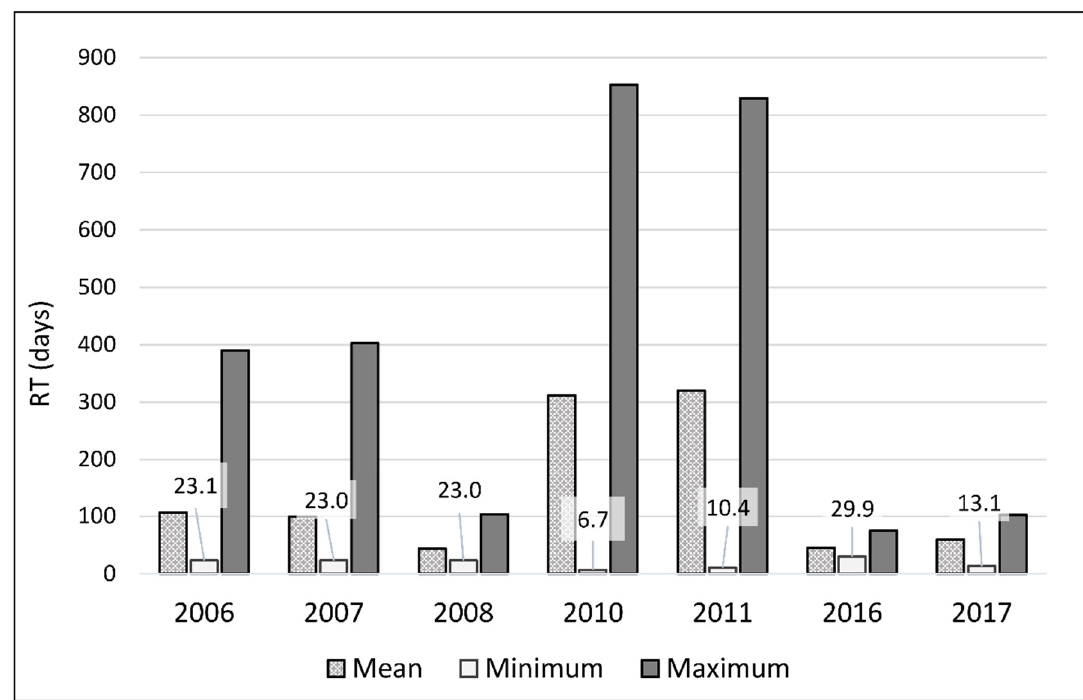
Figure 7. Mean, minimum and maximum values of residence time of the entire Albufera Lake recorded from January to December during 2006, 2007, 2008, 2010 and 2011, and from May 2016 to April 2017.